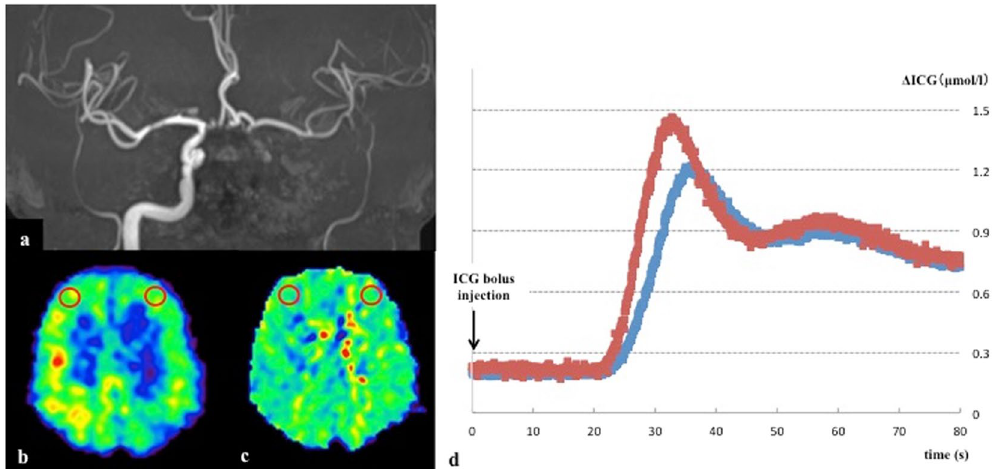
Figure 3. A representative case. A 66-year-old male patient who experienced a small cerebral infarction in the left frontal lobe and was found to have an occlusion of the left internal carotid artery by MRA ( a ). The 15 O-labelled gas PET study revealed a reduced rCBF (rCBF ratio was 0.58) ( b ) and an elevated rOEF (rOEF ratio was 1.18) ( c ) in the target regions of interest (red circles). ( d ) The NIRS/ICG measurement provided an ICG time-intensity curve from the left site (blue line) as well as the right site (red line). the calculated Δ ICGmax ratio was 0.83, TTP ratio was 1.10, the RT ratio was 1.30, and the BFI ratio was